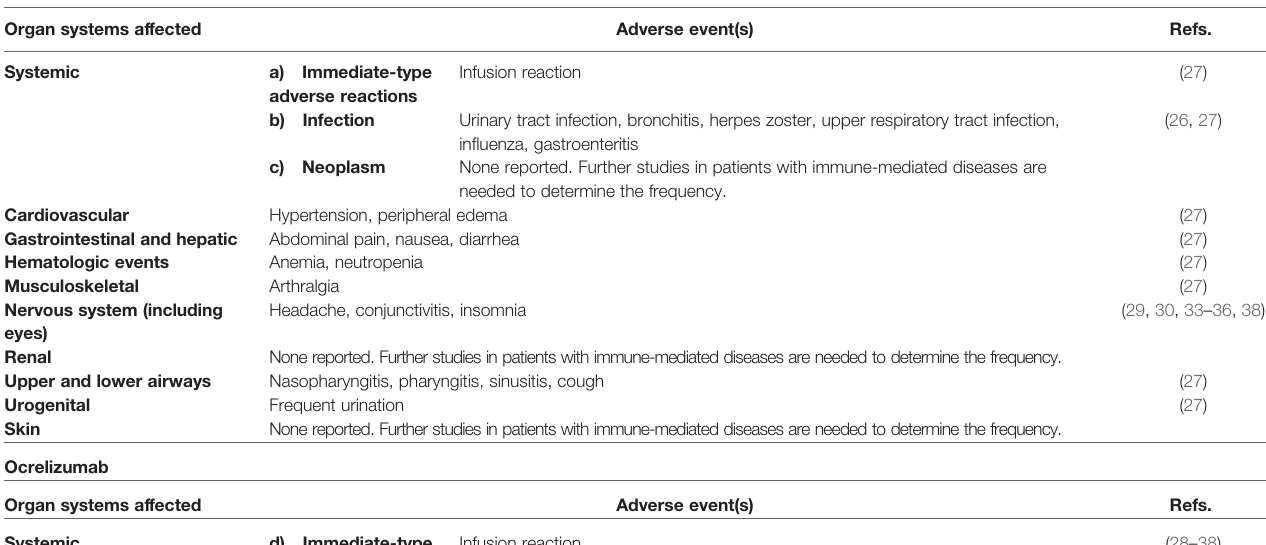
TABLE 5 | Adverse events.